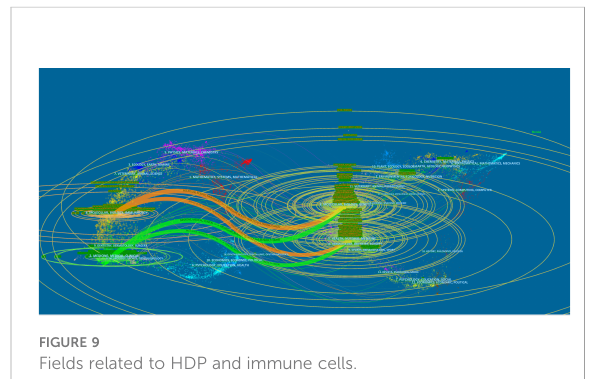
FIGURE 9 Fields related to HDP and immune